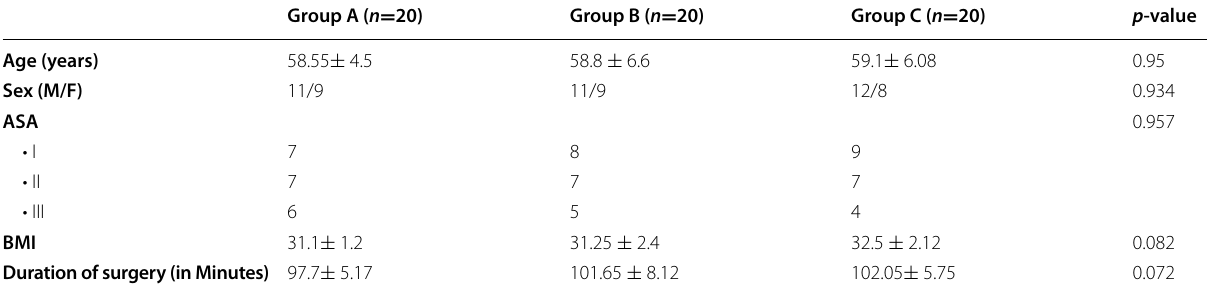
Table 1 Comparison between the three study groups as regard demographic data